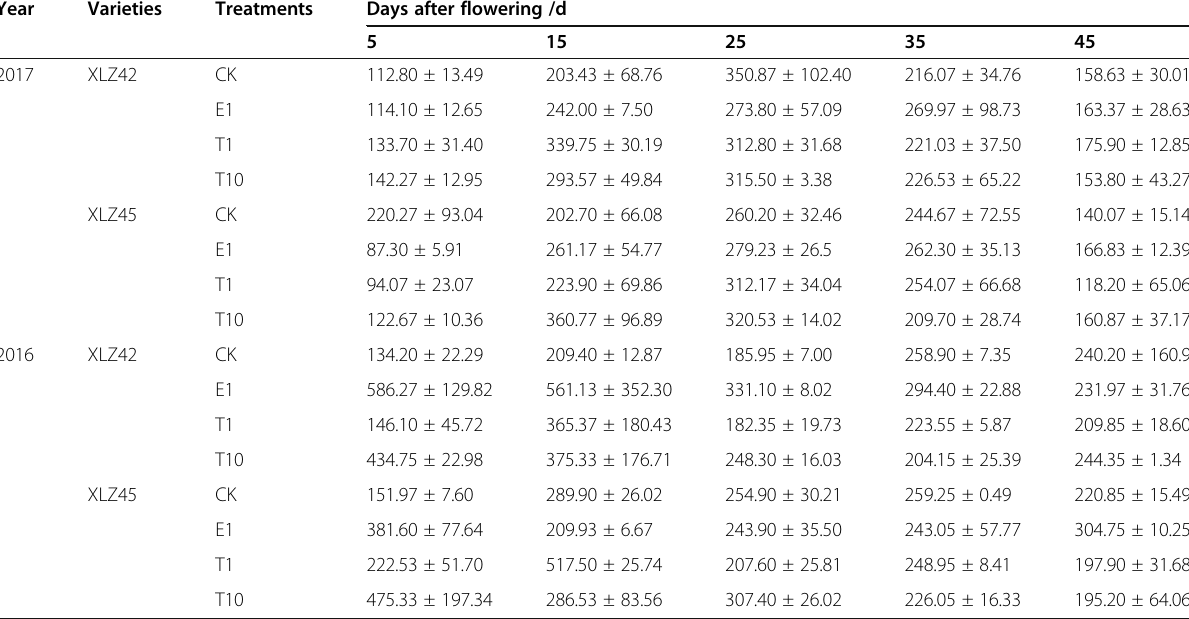
flowering in various treatment groups: Mulch film was removed at 1 and 10 days before the first irrigation (respectively T1(June